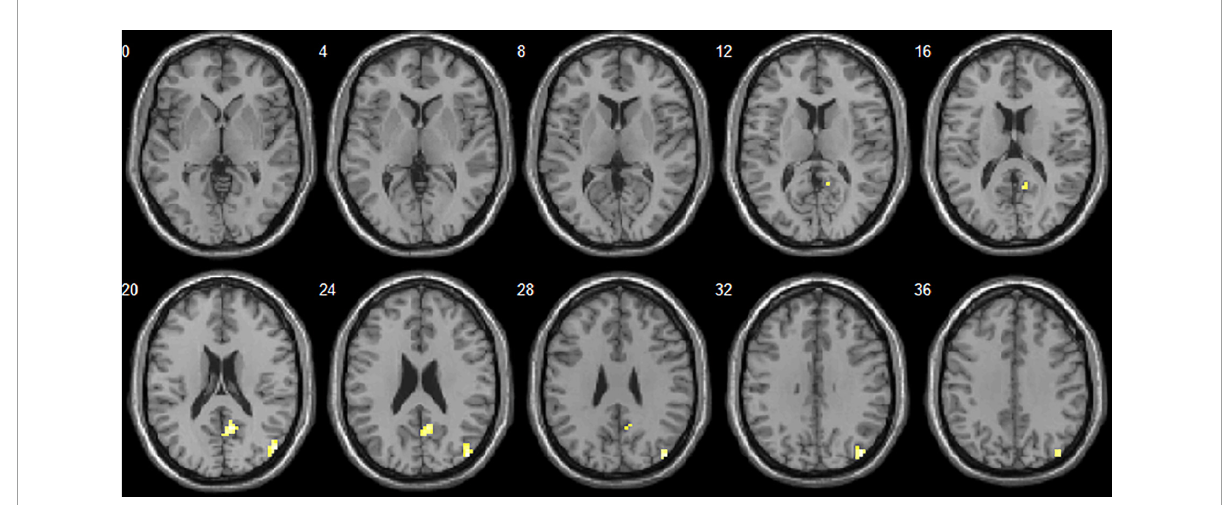
FIGURE2 Brain areas with significant dALFF differences between autism spectrum disorder (ASD) and language development delay (LDD) groups. Regions in red-yellow are brain areas where dALFF was significantly decreased in ASD compared to LDD. The results were multiple compared at the voxel-level ( P < 0.05, FDR corrected). The left side of the image corresponds to the left hemisphere of the